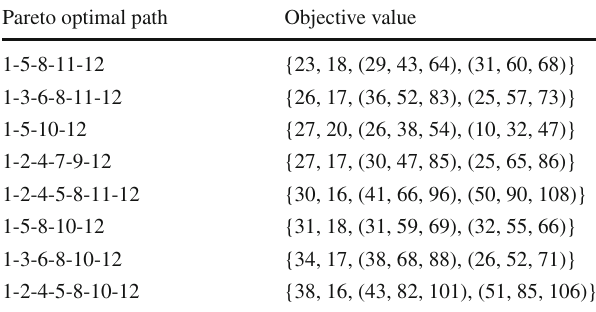
Table 6 The result of Example 2 solved by the RSA Pareto optimal